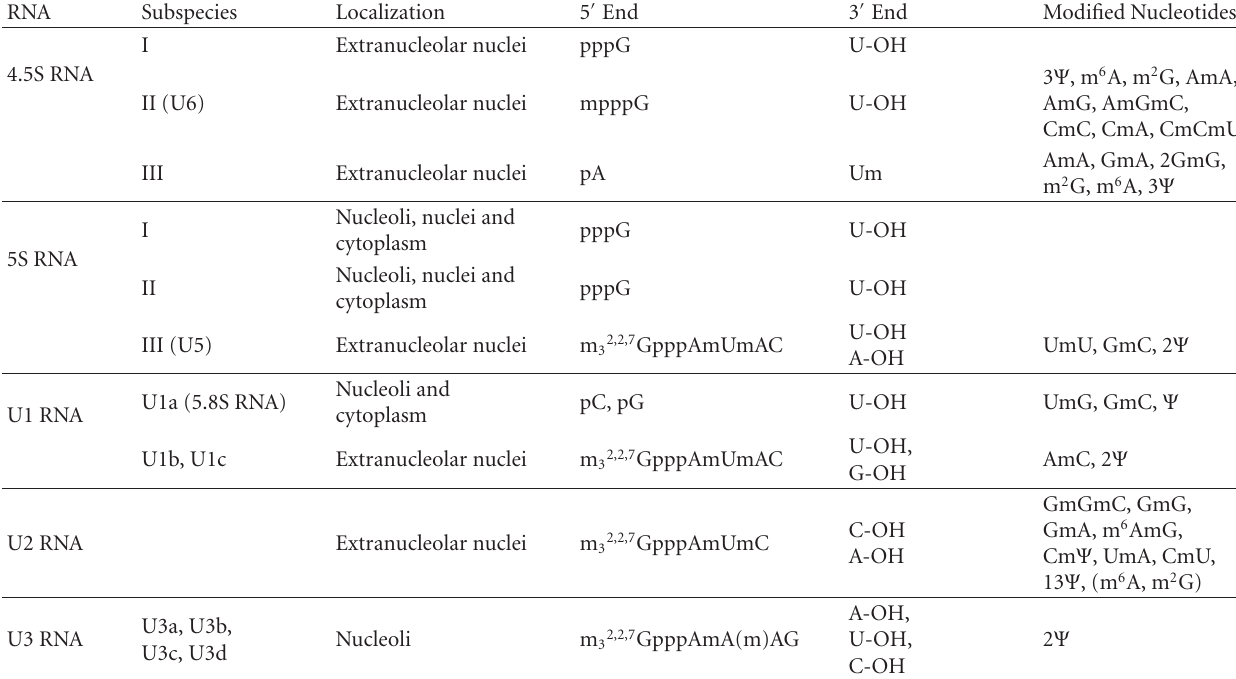
Table 1: Signature sequences and modifications of major snRNAs. The 5 (cid:2) cap and 3 (cid:2) nucleosides, base modified nucleosides, and alkali resistant oligonucleotides were determined by many methods described in the text. The table provides a summary of individual RNA characteristics of rat Noviko ff hepatoma